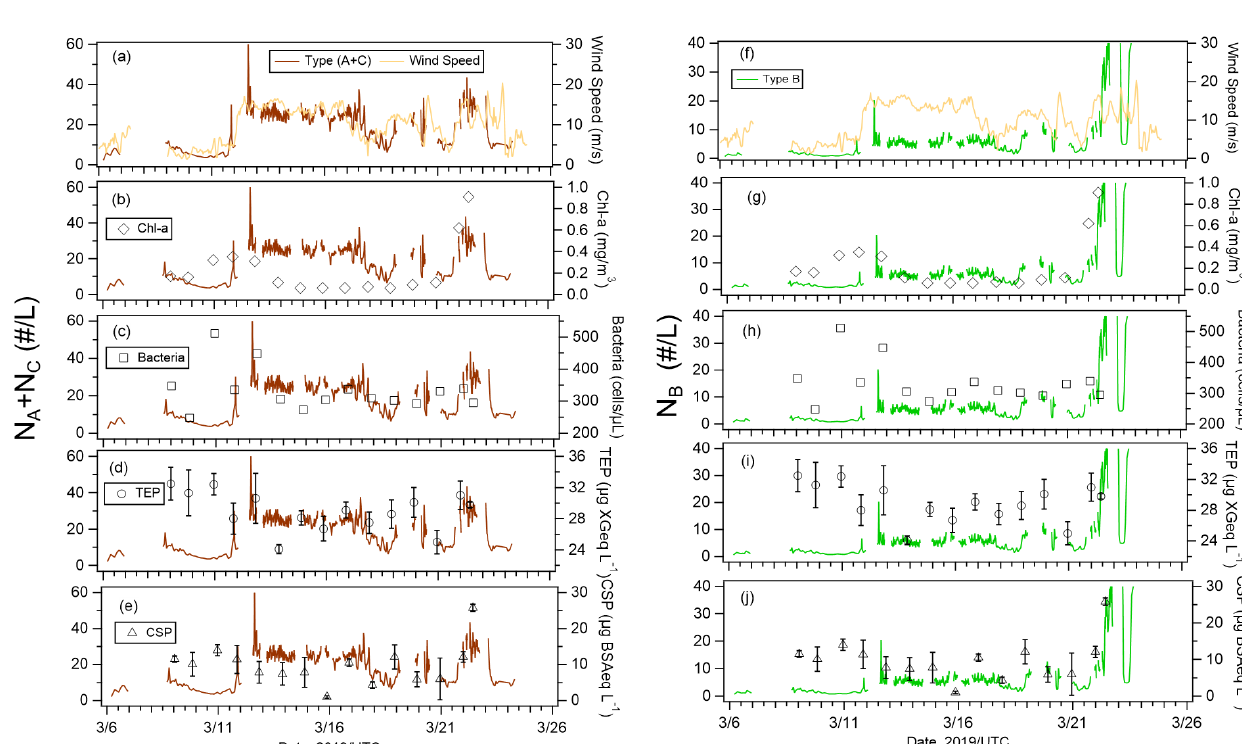
Figure 7. Time series of number concentrations of type A + C particles and (a) wind speed, as well as concentrations of (b) Chl- a , (c) bac- teria, (d) TEPs, and (e) CSPs. Time series of number concentrations of Type B particles and (f) wind speed, as well as concentrations